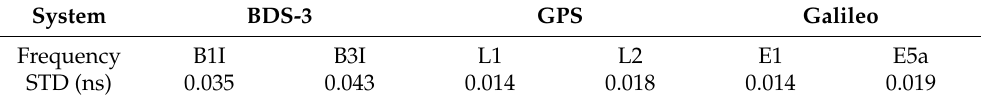
Figure 5. Time series of the observable-specific signal bias at B1I and B3I frequencies of the BDS-3 for DOY 301, 2021. Table 2. Average STD values of the BDS-3/ GPS/ Galileo’s OSB for DOY 301, 2021.